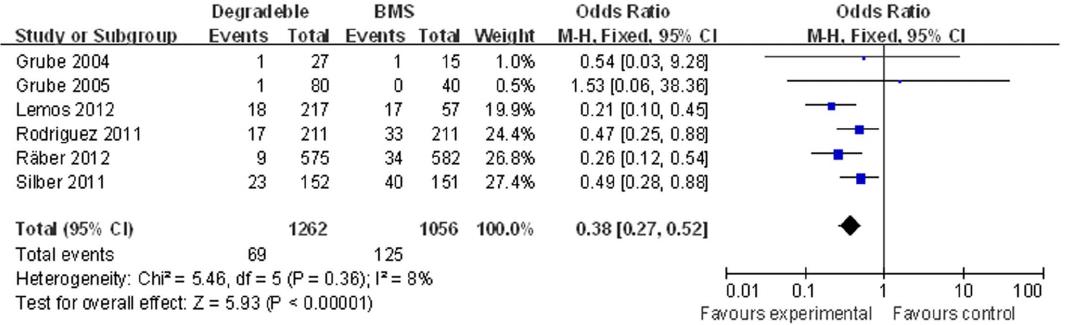
Figure 5. Individual and summary odds ratios for TLR in patients treated with BP-DES vs. BMS.